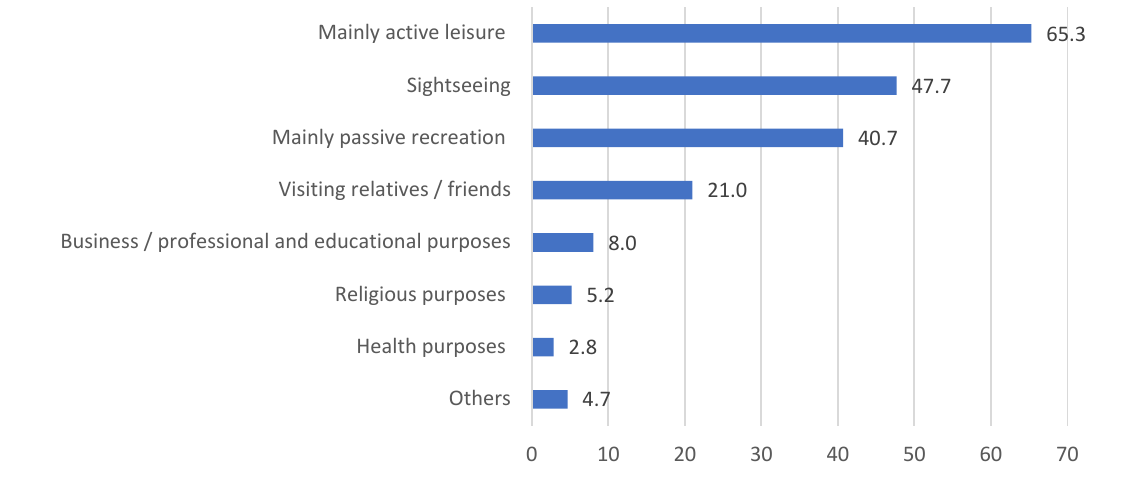
Figure 3. Main purposes of tourist trips among the respondents in 2020. The respondents could indicate more than one answer. Source: self-conducted research.